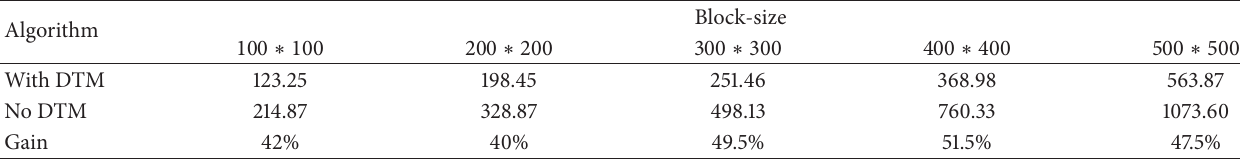
Table 3: Block-count is 5 ∗ 5 on PolyTech Lille platform.